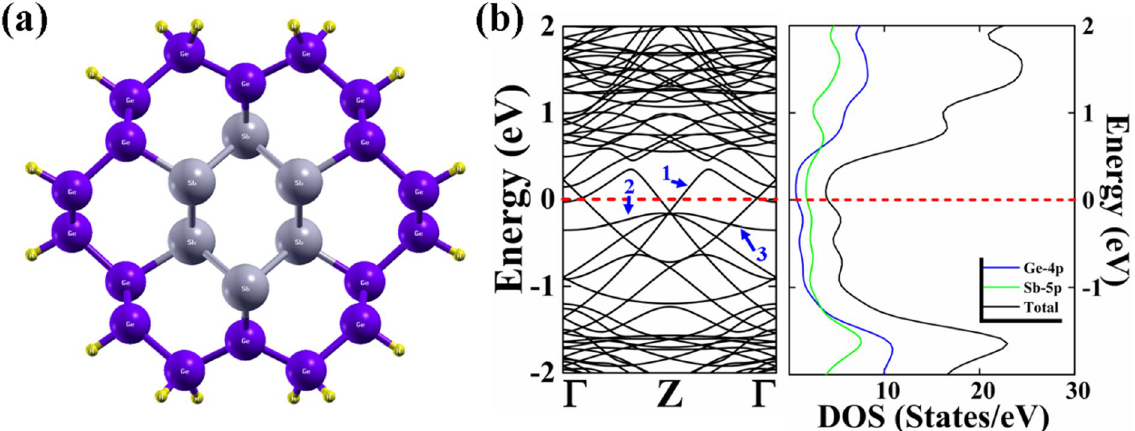
Figure 1. ( a ) Optimized electronic structure of the Sb/Ge core/shell nanowire. The electronic band structure and partial density of states of the NW are shown in ( b ). The Fermi energy is set at 0 eV. Grey balls denote Sb atoms; violet balls denote Ge atoms and the yellow balls the hydrogen